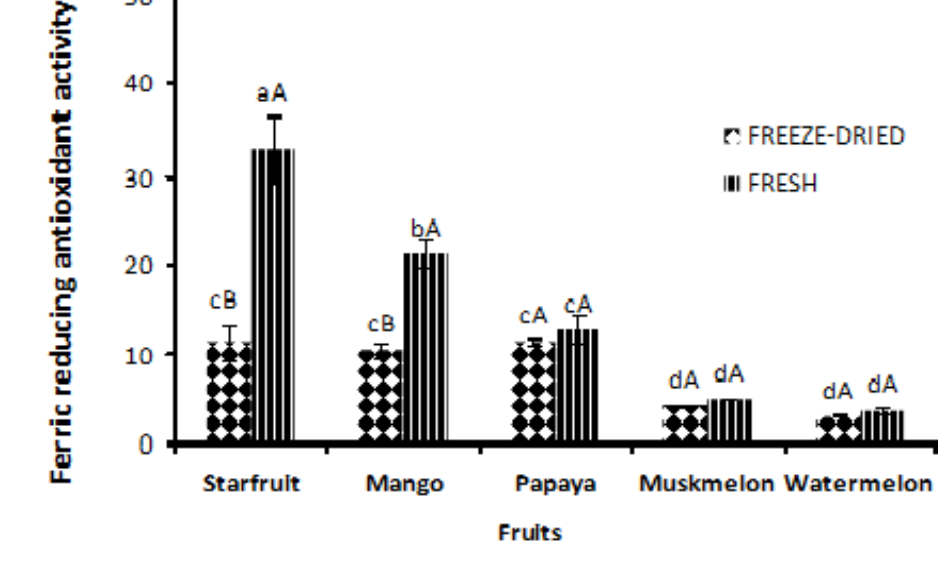
Figure 2. Ferric reducing power of fresh and freeze-dried fruits. Data expressed in µmol/g fresh weight. Values denoted with the same small letter are not significantly ( p > 0.05) different among fruits tested. Values with the same capital letter are not significantly ( p > 0.05) different between the fresh and freeze-dried fruits. Data stand as means of three